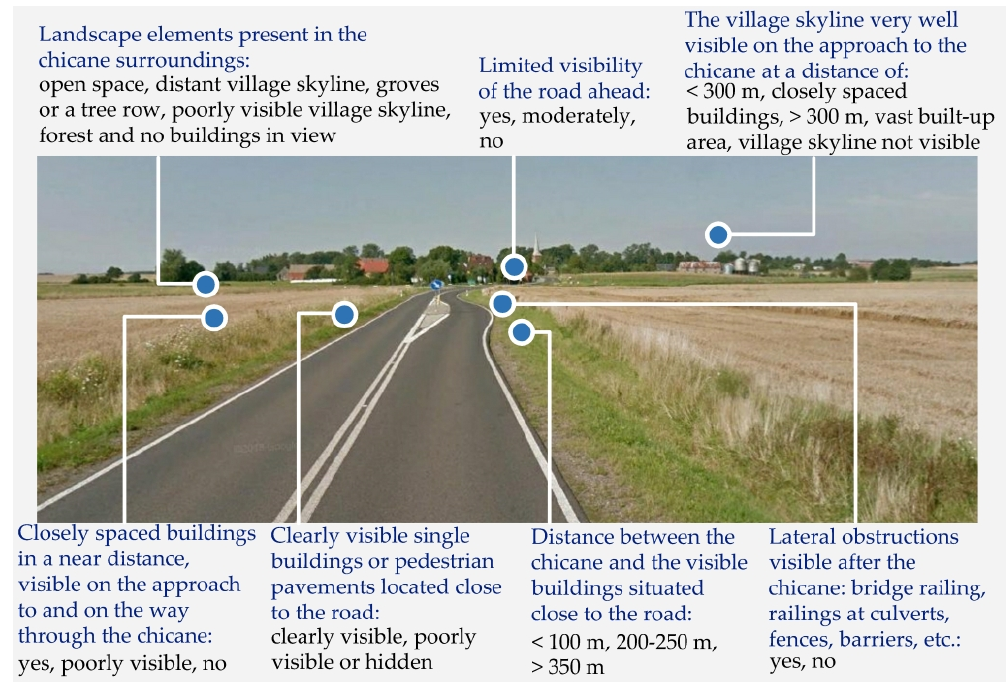
Energies 2020 , 13 , x FOR PEER REVIEW 14 of 33 Figure 11. Central and peripheral vision area of a driver: ( a ) on the basis of the data from [55]; ( b ) at speeds up to 50 km / h: ( c ) at the speed of 70 km / h; ( d ) at the speed of 100 km / h.